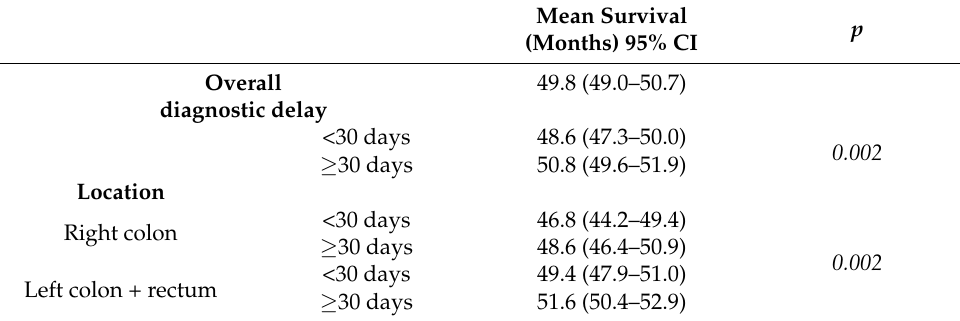
Table 2. Survival analysis according to diagnostic delay, stratified by location.